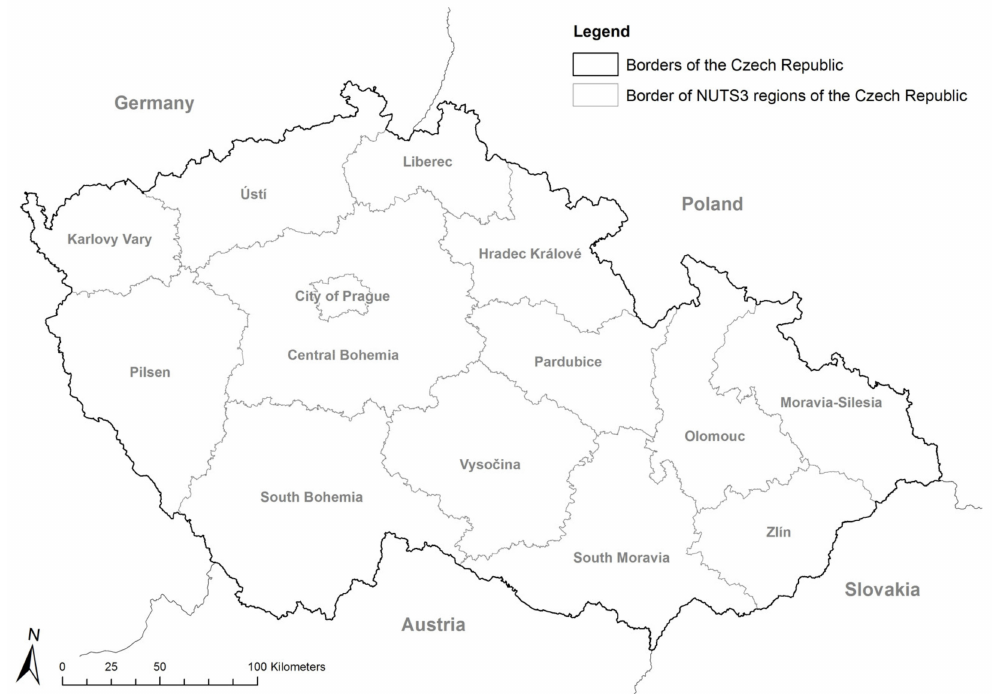
Figure 1. The map of the study area. Borders of NUTS3 regions in the Czech Republic (source: Register of Territorial Identification, Addresses and Real Estate, https://www.cuzk.cz/ruian/, accessed on 10 October